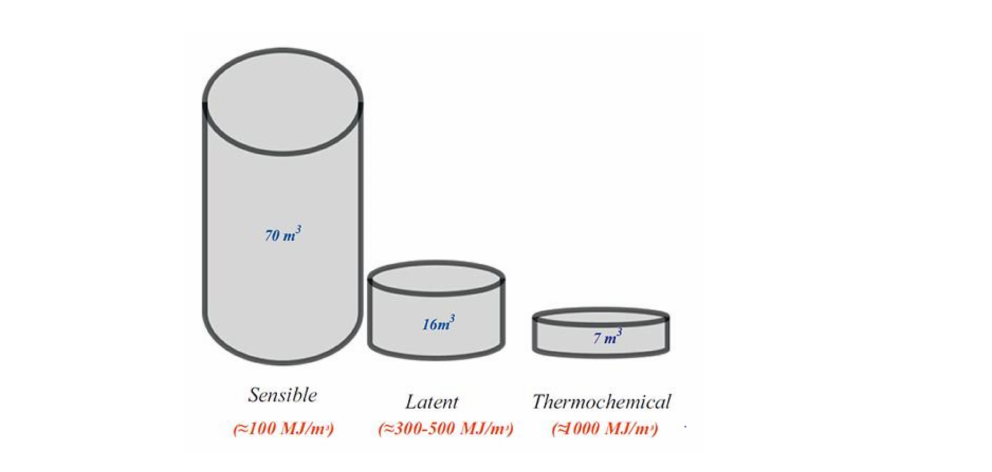
Figure 4. Volume needed to full cover the annual storage needs of an energy efficient passive house (6480 MJ) [33].